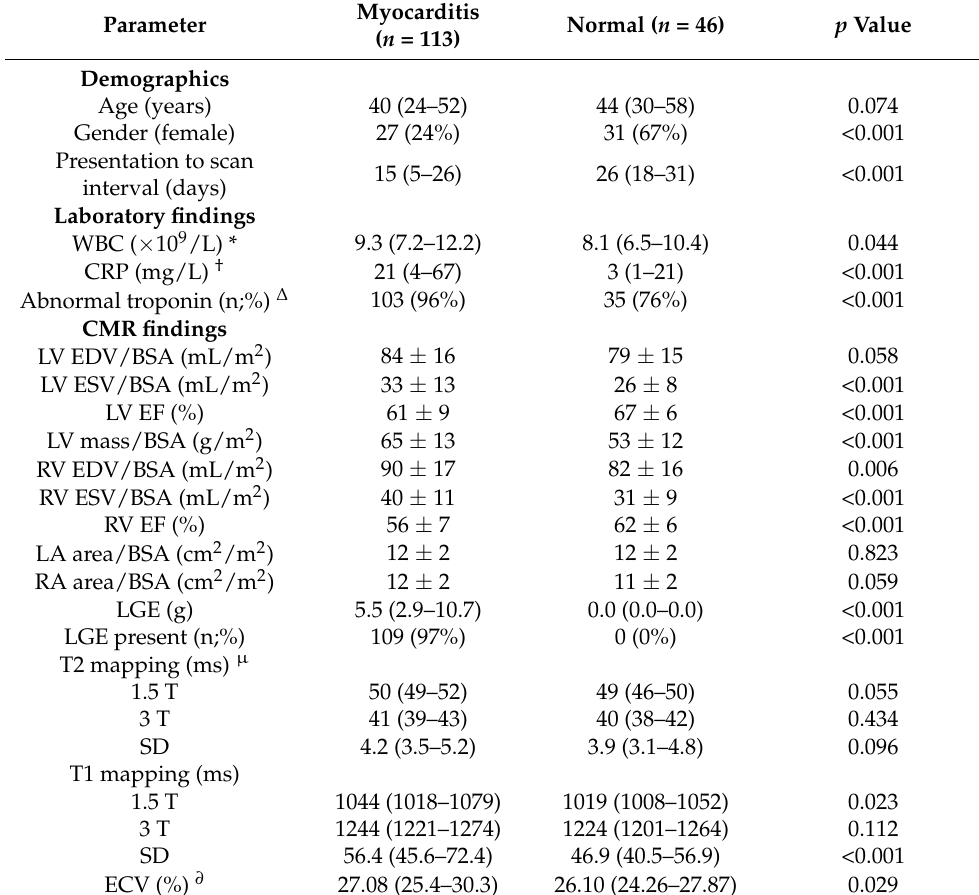
Table 2. Characteristics of patients undergoing CMR within 40 days of presentation ( n =